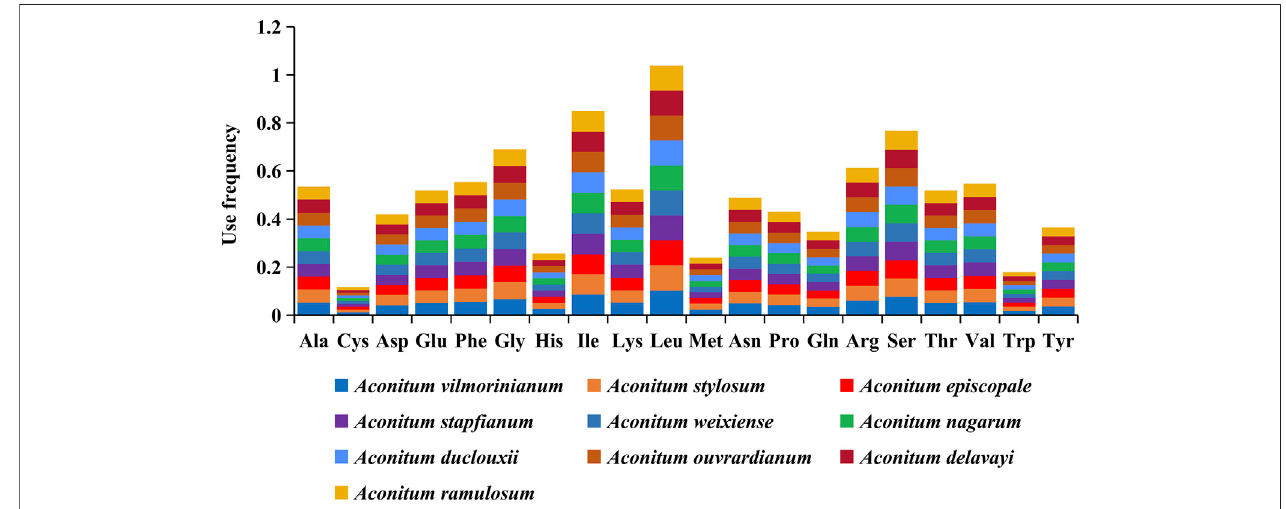
FIGURE 3 | Frequency of amino acids encoded in the coding region by codons of chloroplast genes from ten Aconitum species.